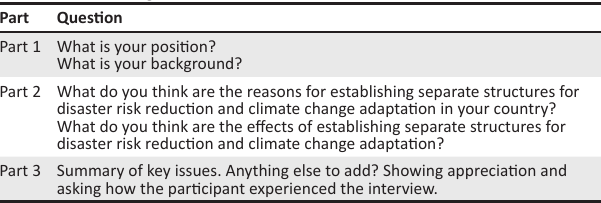
TABLE 1: Interview guide. Part Question Part 1 What is your position? What is your